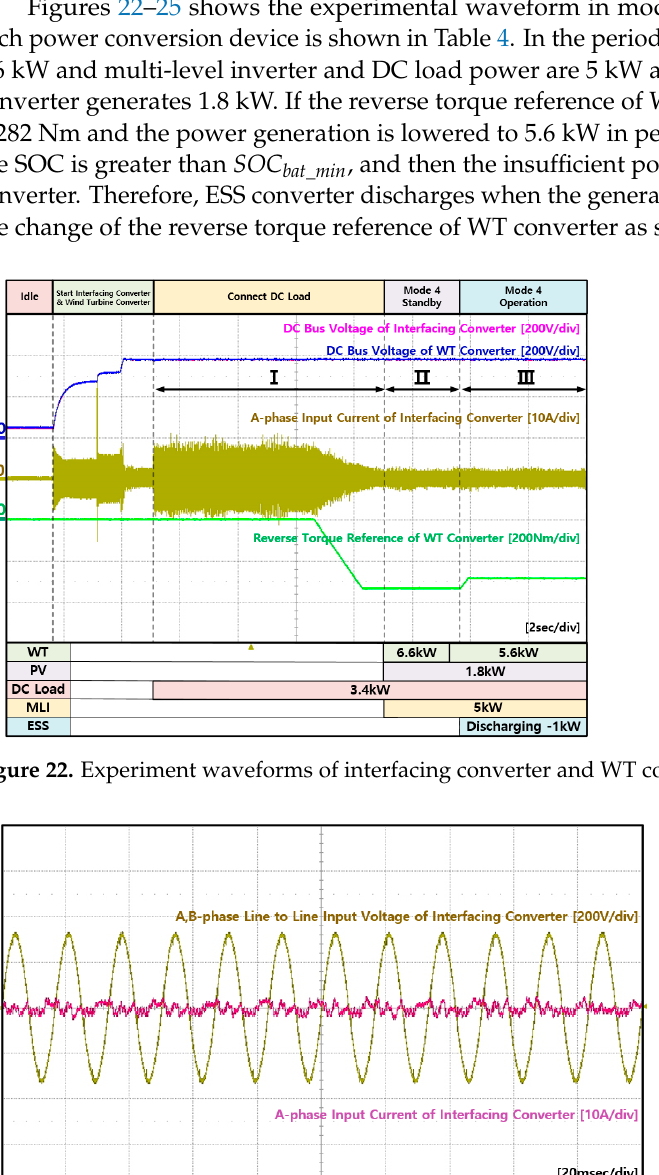
Figure 24. Experiment waveforms of DC load and multi-level inverter in mode 4. Figure 25. Experiment waveforms of PV converter and ESS converter in mode 4. Figures 26–29 shows the experimental waveform in mode 5. The output power of each power conversion device is shown in Table 5. In the period I of mode 5, WT converter generates 6.6 kW and multi-level inverter and DC load power are 5 kW and 3.4 kW re- spectively. PV converter generates 1.8 kW. In the period II , if the reverse torque reference of WT converter is changed to − 282Nm and the power generation is lowered to 5.6 kW, EMS determines the discharging power reference as much as − 1 kW. After that, the reverse